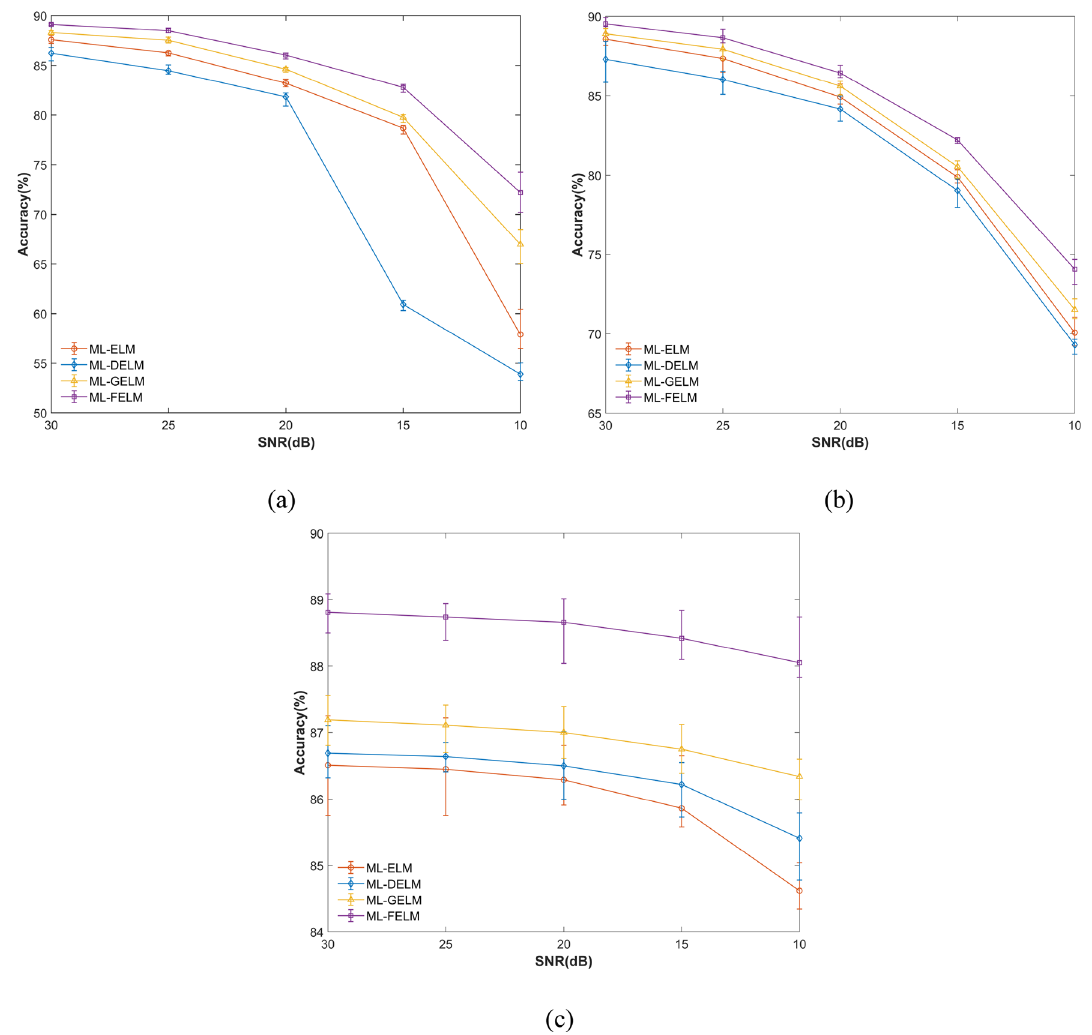
Fig. 9 The variation of classification accuracy with different SNR on datasets: a Satellite image, b letter recognition, and c